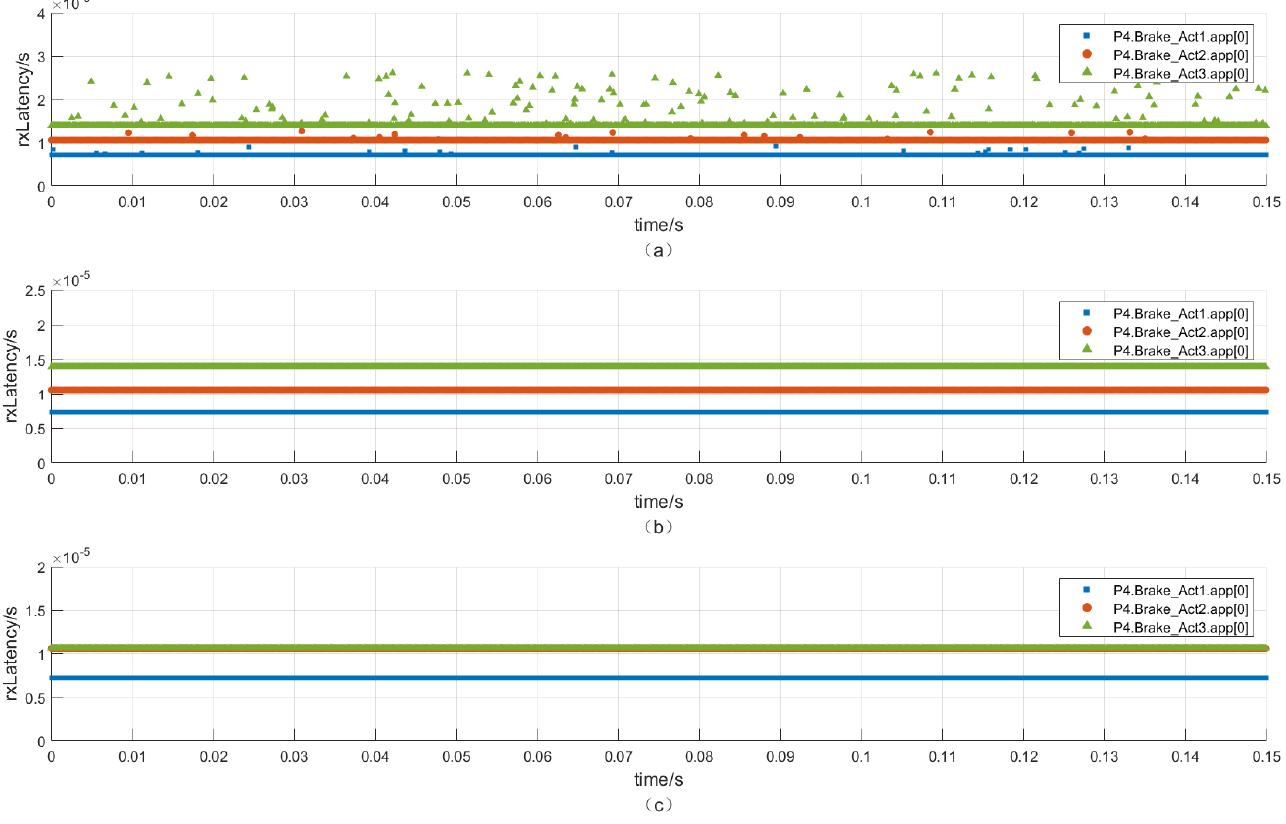
Figure 6. End-to-end delay of brake control traffic ( a ) without scheduling and without redundancy; ( b ) with scheduling and without redundancy; ( c ) with scheduling and with redundancy.